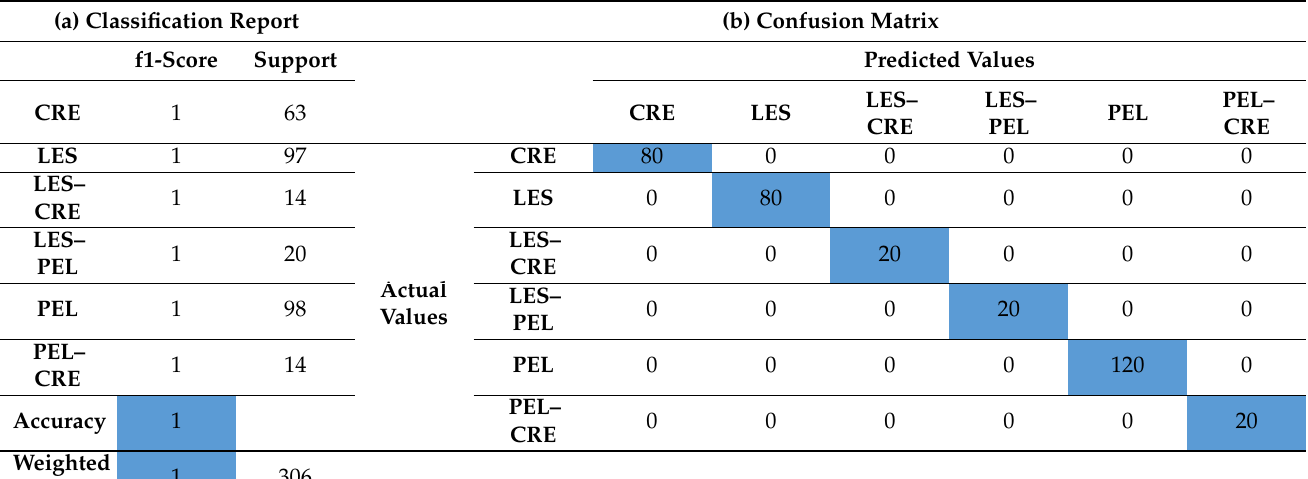
Table 3. ( a ) Classification report and ( b ) confusion matrix for the LDA external